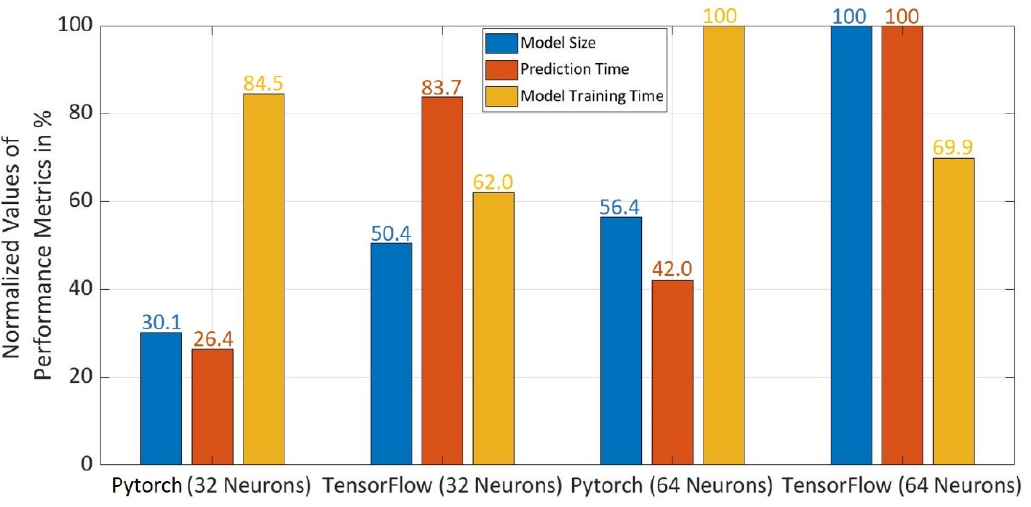
Figure 12. Comparison of the Performance Metrics considering Model Size, Prediction Time and Model Training Time for Pytorch and TensorFlow with 32 and 64 Neurons in each Hidden Layers.